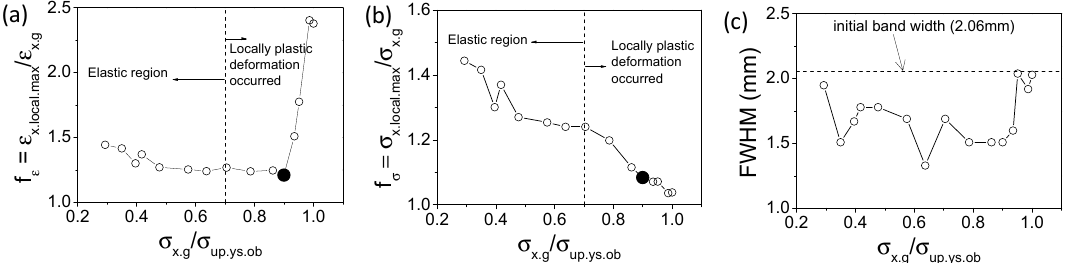
Figure 10. The dependence of ( a ) the strain concentration factor, ( b ) the stress concentration factor, and ( c ) the size of the stress concentration region on the normalized applied stress.